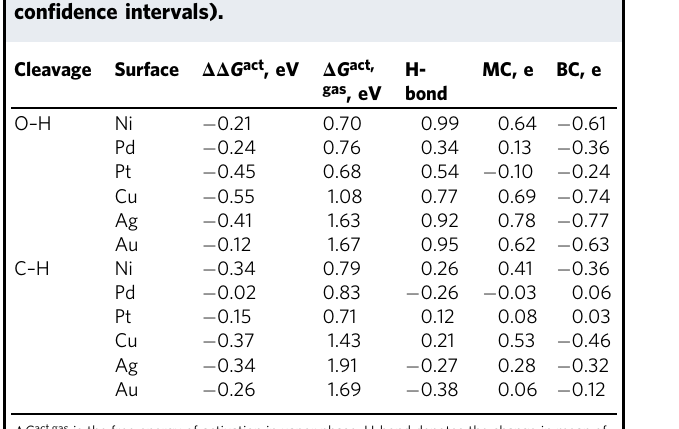
Table 2 Average aqueous-phase effects on the activation free energy ( ΔΔ G act = Δ G act,liq − Δ G act,gas ) as well as three solvation effect descriptors for the O – H and C – H bond cleavages of ethylene glycol over the (111) surface facet of six transition metals at 423 K (see Table 1 for 95% con fi dence intervals).